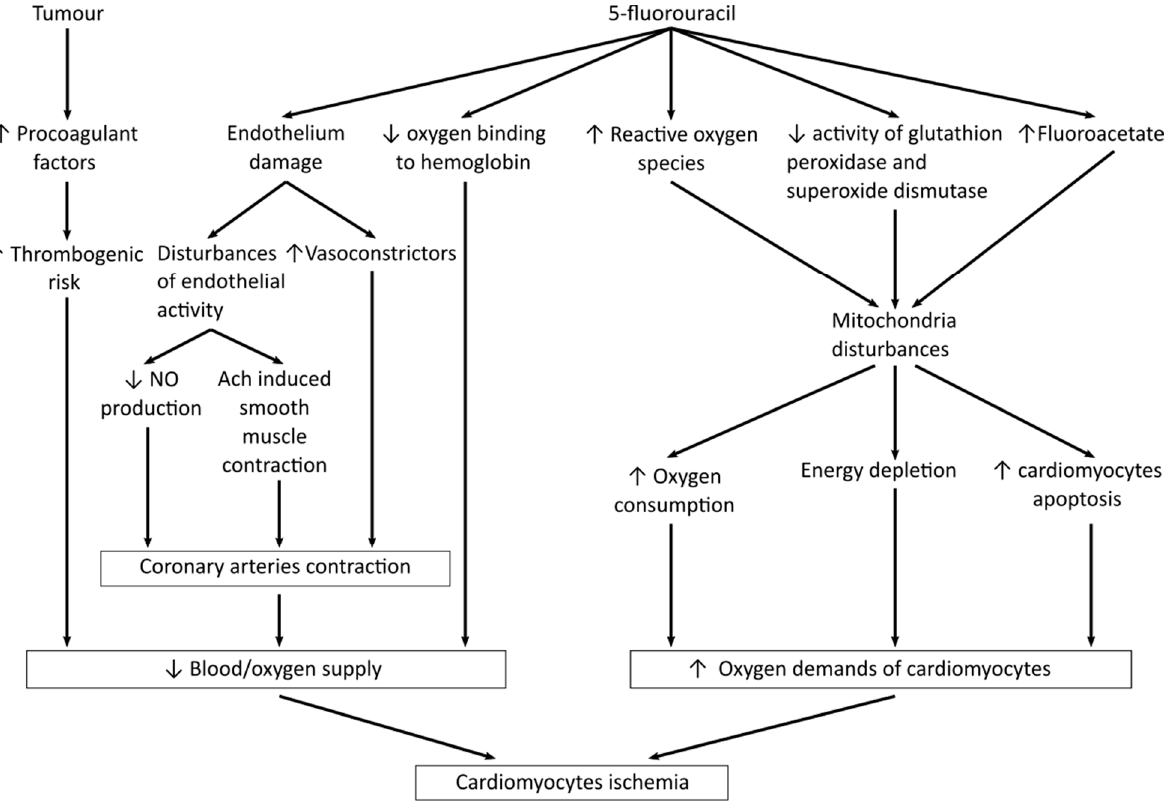
Figure 6. Mechanisms leading to cardiotoxicity.